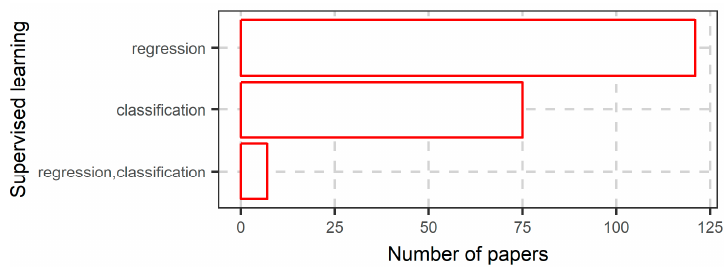
Figure 6. Grouping of RF-related articles based on supervised learning tasks.